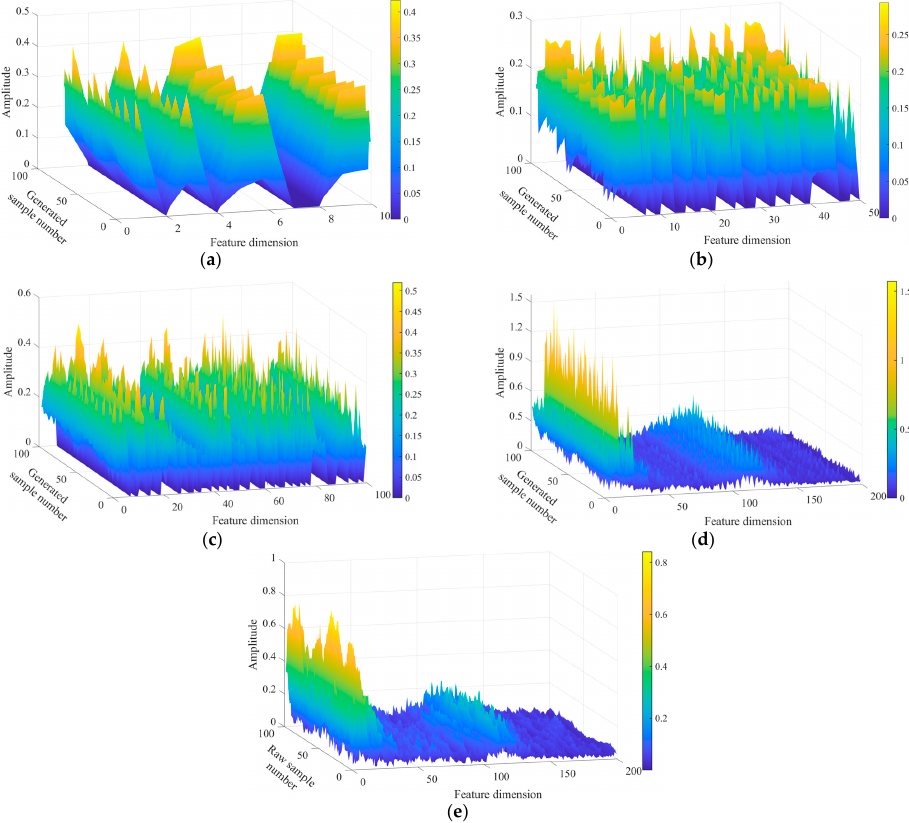
Figure 13. Comparison between real and generated signals for dataset C: ( a ) Raw signals, ( b ) Gen- erated signals.